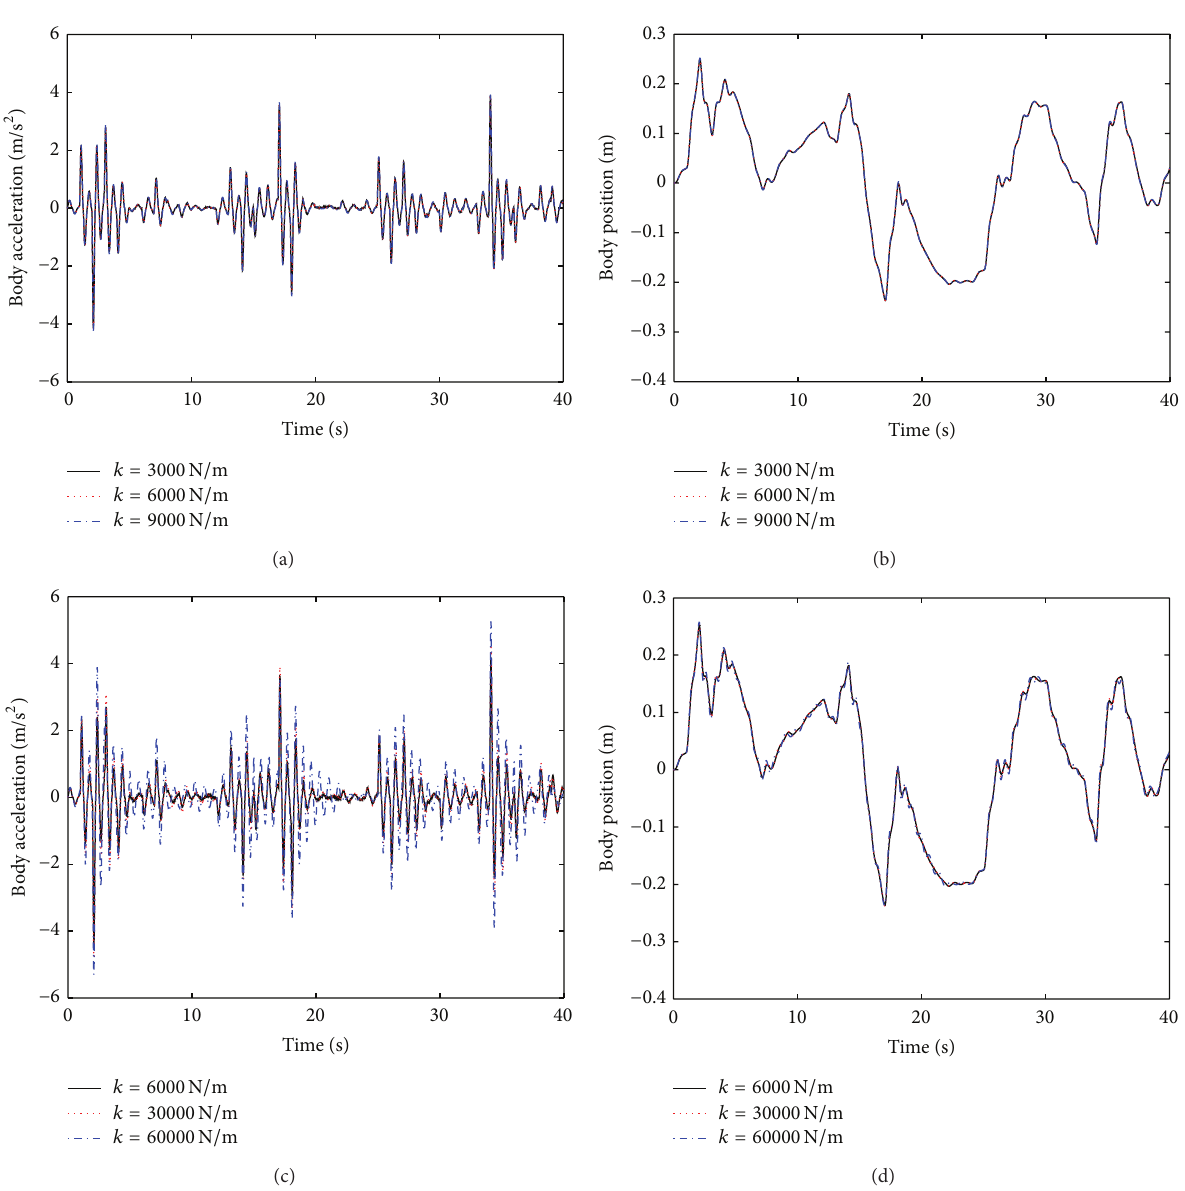
Figure 9: Acceleration and displacement of the sprung mass with different suspension